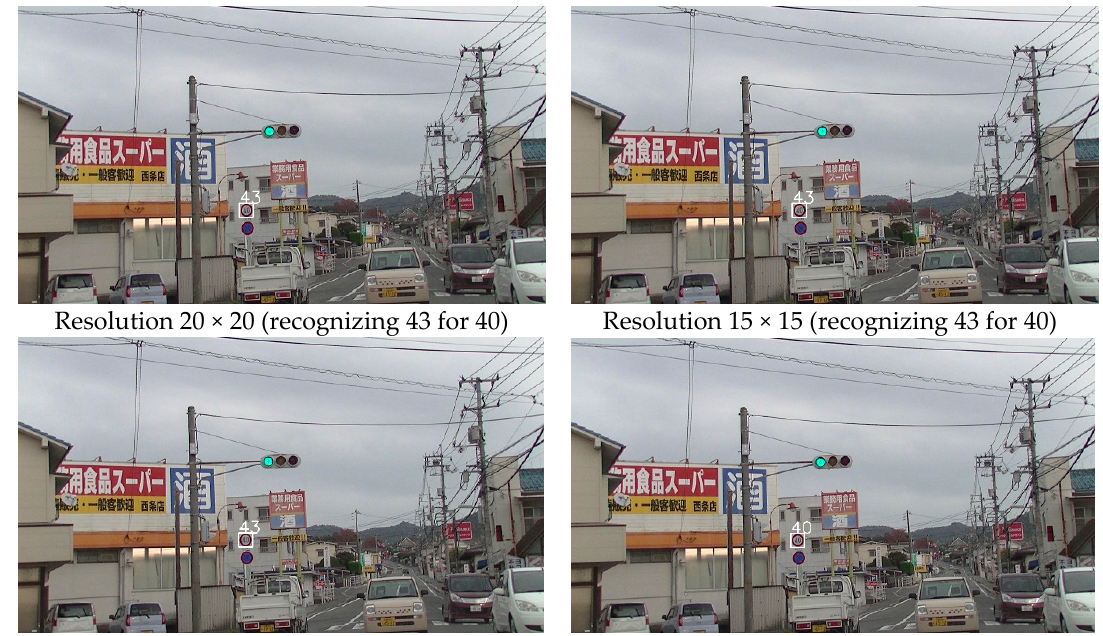
Figure17. Example of recognition results for 30 km speed-limit sign. Figure 17. Example of recognition results for 30 km speed-limit sign.